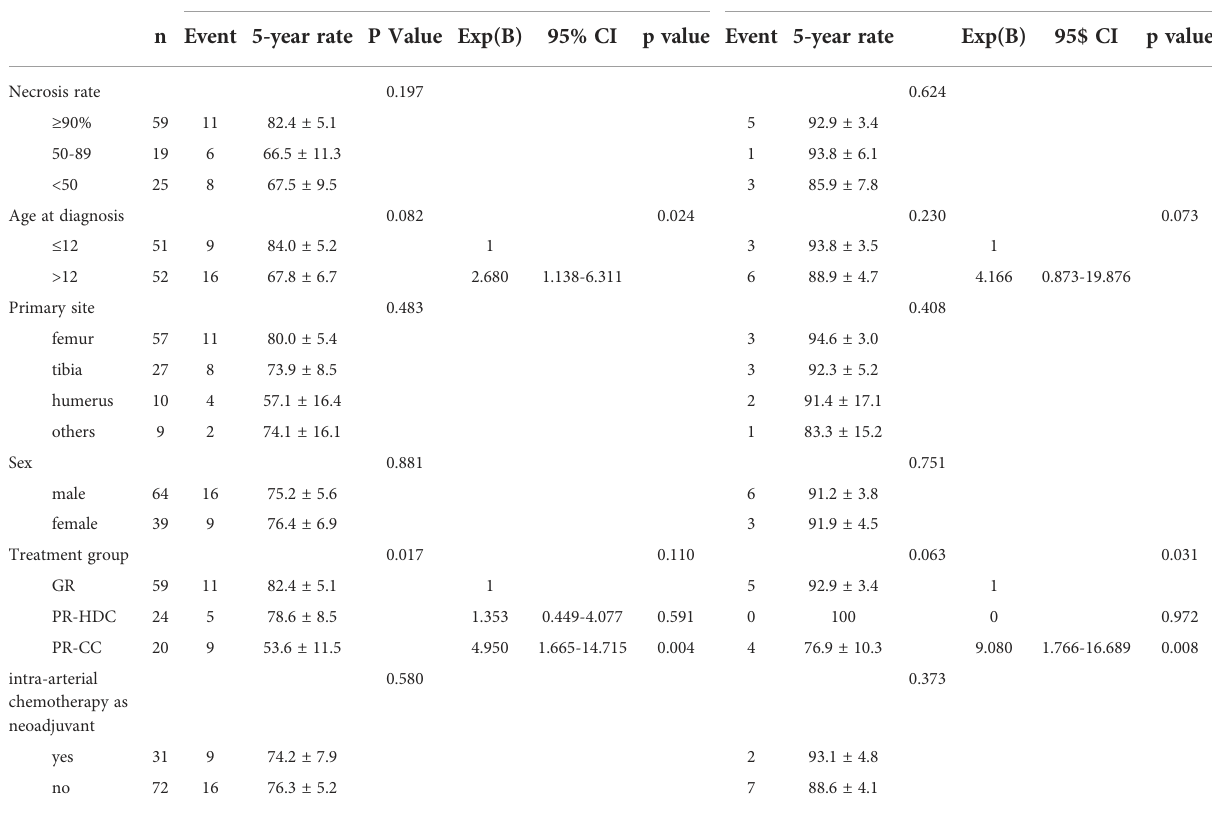
TABLE 5 Univariate and multivariate analyses of event-free and overall survivals. Event-free